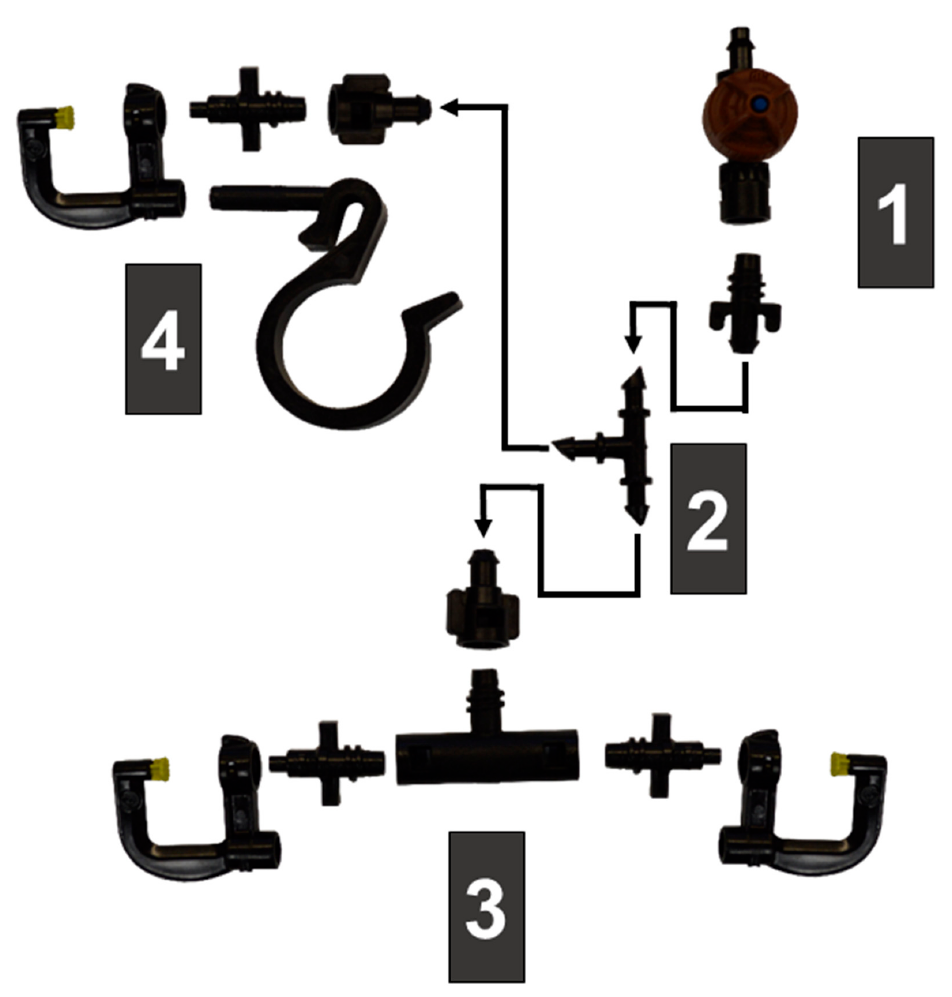
Figure 3. Microsprinkler components for a set of sprayers. (1) 241 kPa Leak prevention device that is inserted into 2.5 cm upper line with bayonet adapter to 0.635 cm line. (2) 3 way split inserted into 0.635 cm line. (3) ‘T’ bayonet fitting attached to a pair of 0.8 mm nozzles and Hadar 7110 spray deflectors. (4) Single microsprinkler fixed to post on hose/wire clip.